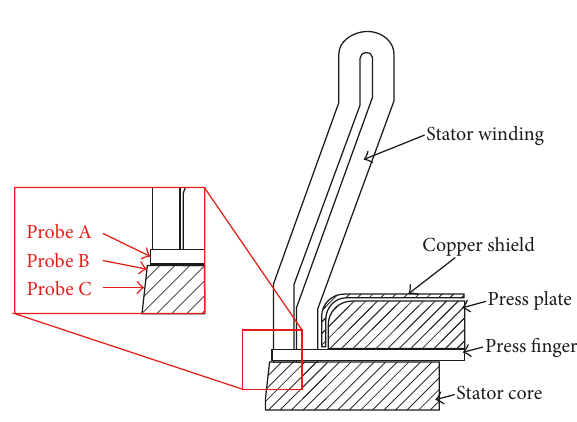
Figure 5: Distribution of the test points.